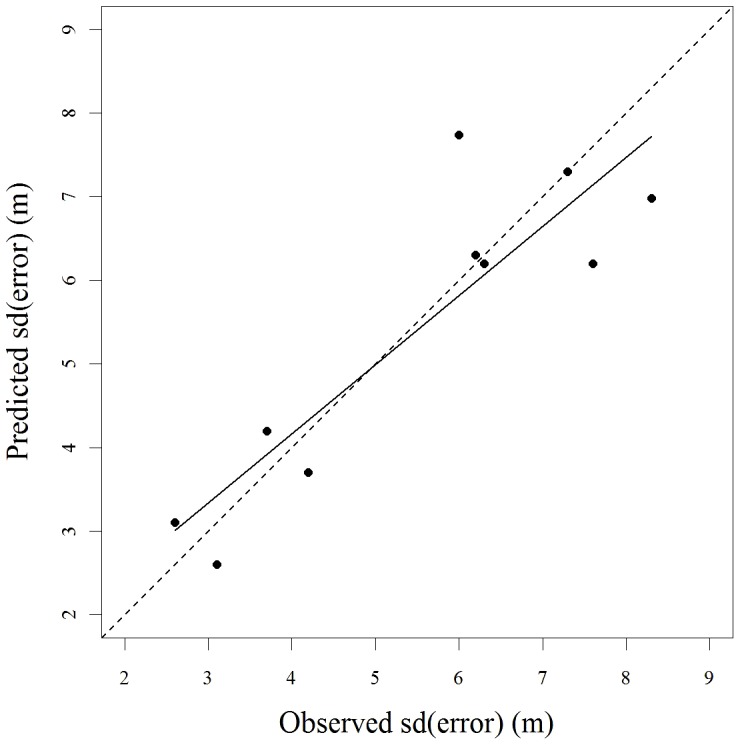
Regression of predicted versus observed standard deviation of error for leave-one-out cross-validation of the logistic model describing the relationship between percentage canopy cover and the standard deviation of the positional error of stationary GPS collars in central New York (R2 = 0.79).